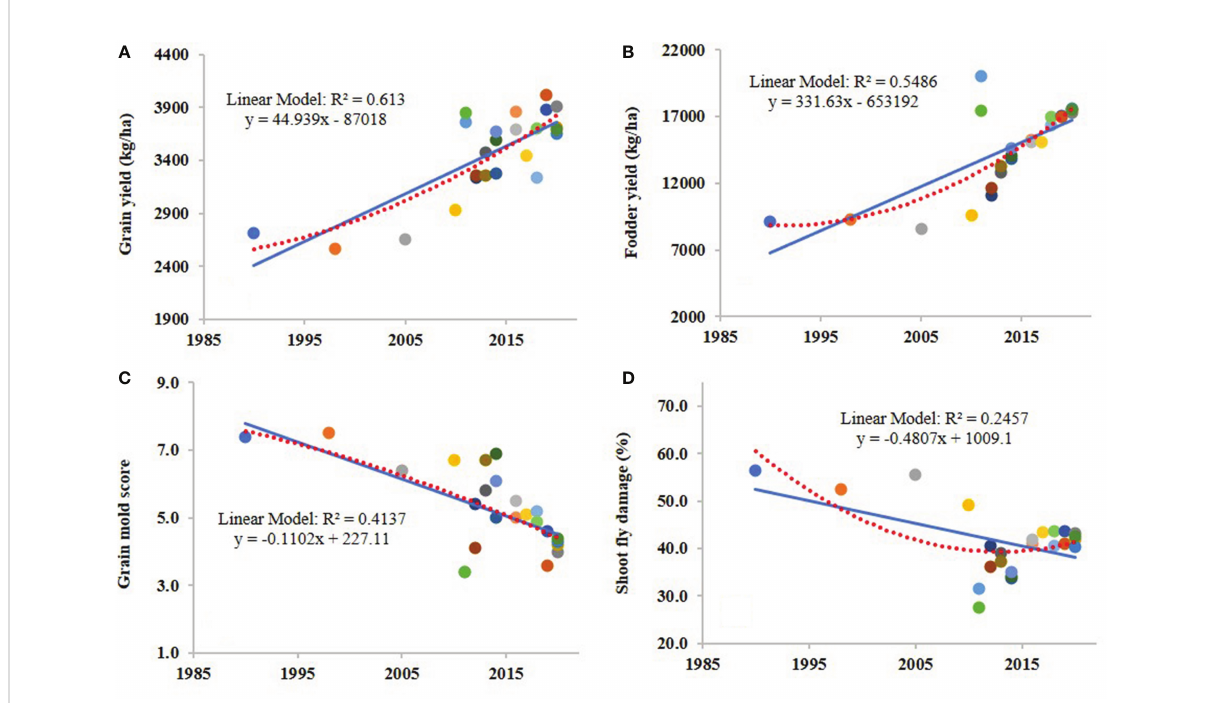
FIGURE 1 Regressions between the year of development of 24 sorghum varieties and grain yield (A) , fodder yield (B) , grain mold score (C) and shoot fl y damage (%) (D) for overall environments. Each data point is the best linear unbiased predictor (BLUP) of grain yield, fodder yield, grain mold score and shoot fl y damage (%) for a variety in the respective graphs, generated for overall